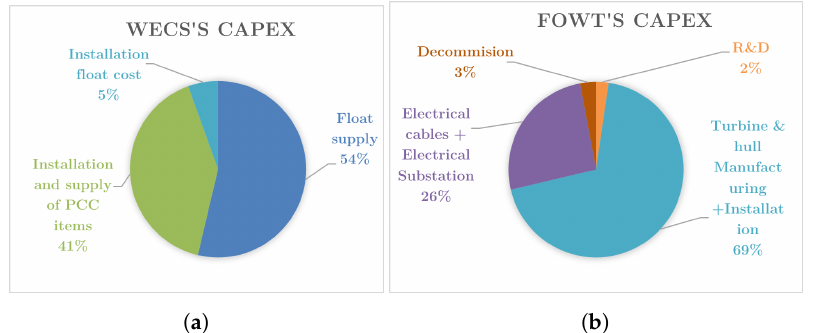
Figure 22. Breakdown cost for hybrid configuration ( a ) Wind turbine and Platform, ( b )